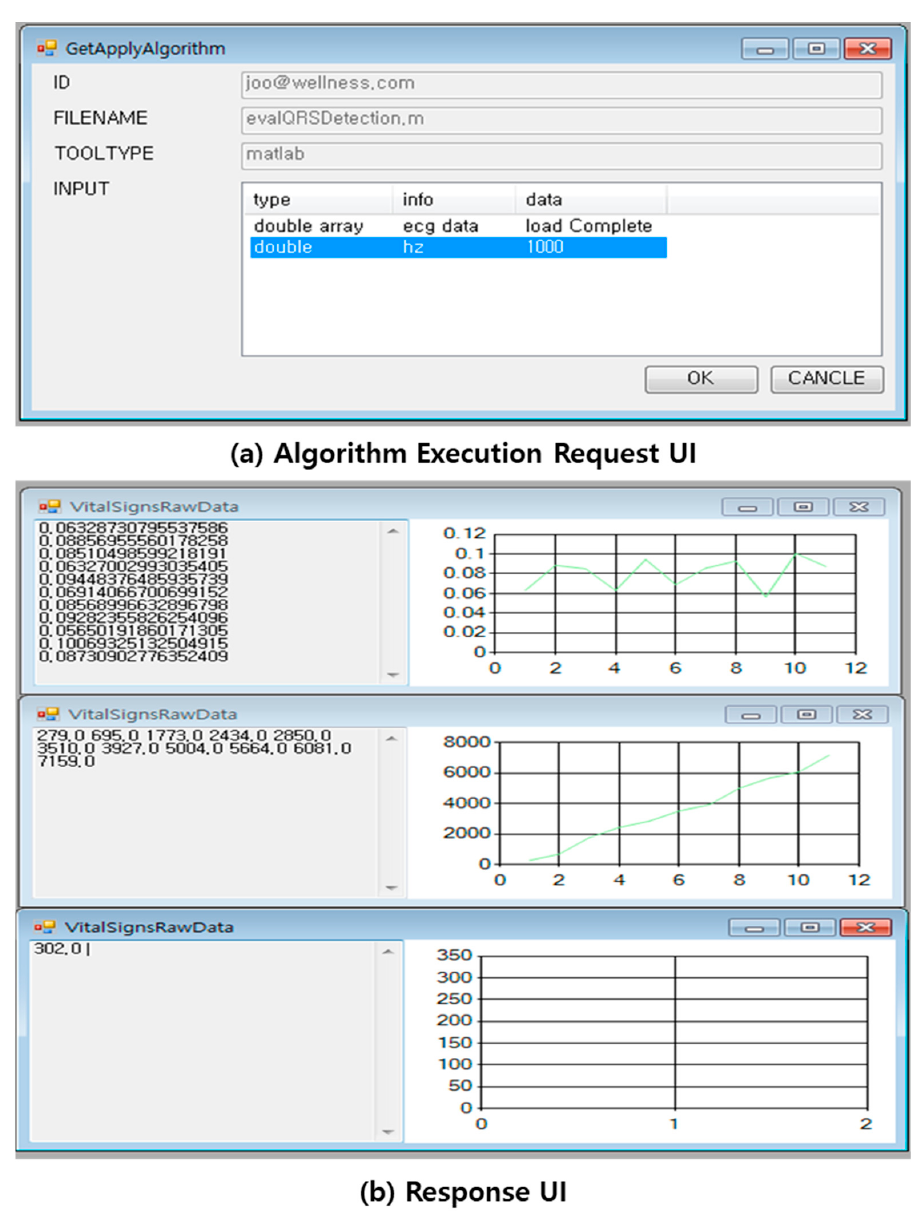
Figure 13. Implementation of vital sign system user interfaces; ( a ) UI for requesting the algorithm execution; ( b ) response UI where the algorithm was executed.